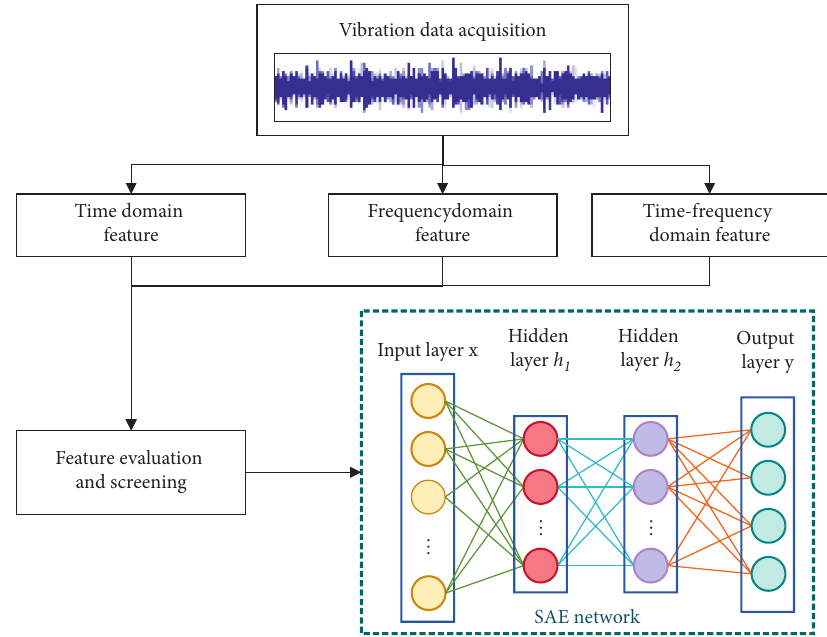
Figure 4: Extraction process of DBHI based on